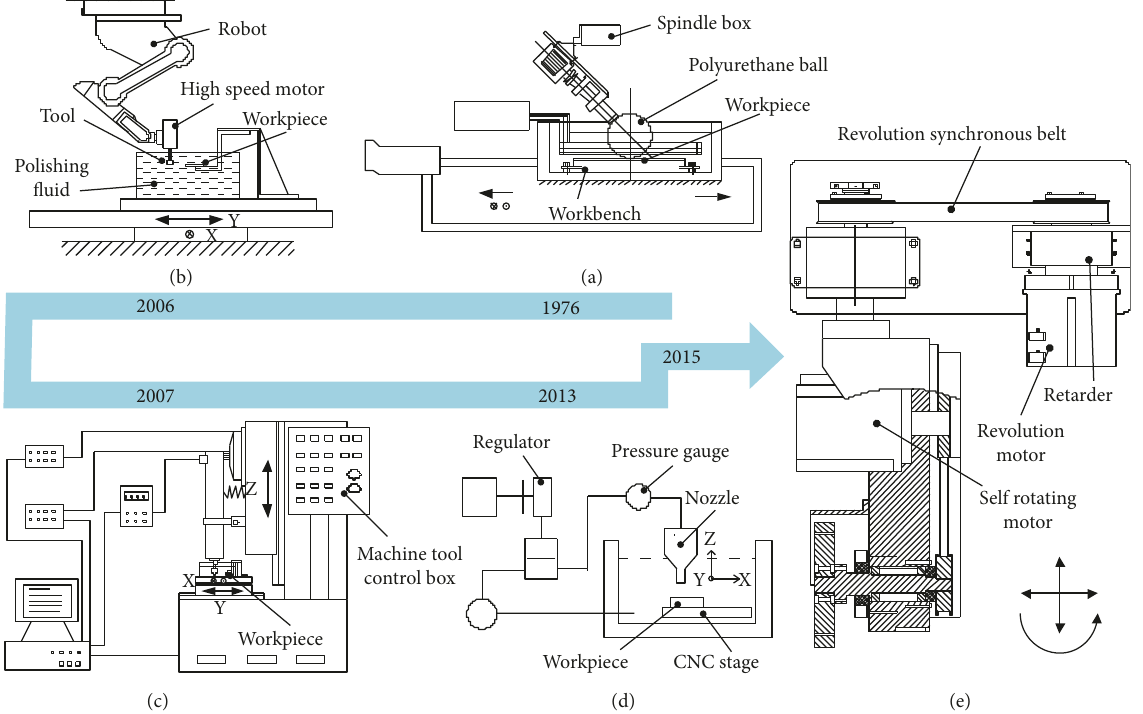
Figure 17: Development of processing device in EEM. (a) Cross spring-type EEM. (b) Robotic type EEM. (c) Structural schematic diagram of elastic constrained-free abrasive particle processing system. (d) Schematic drawing of the nozzle-type EEM system used in this study. (e) Double rotating wheel-type elastic launching processing